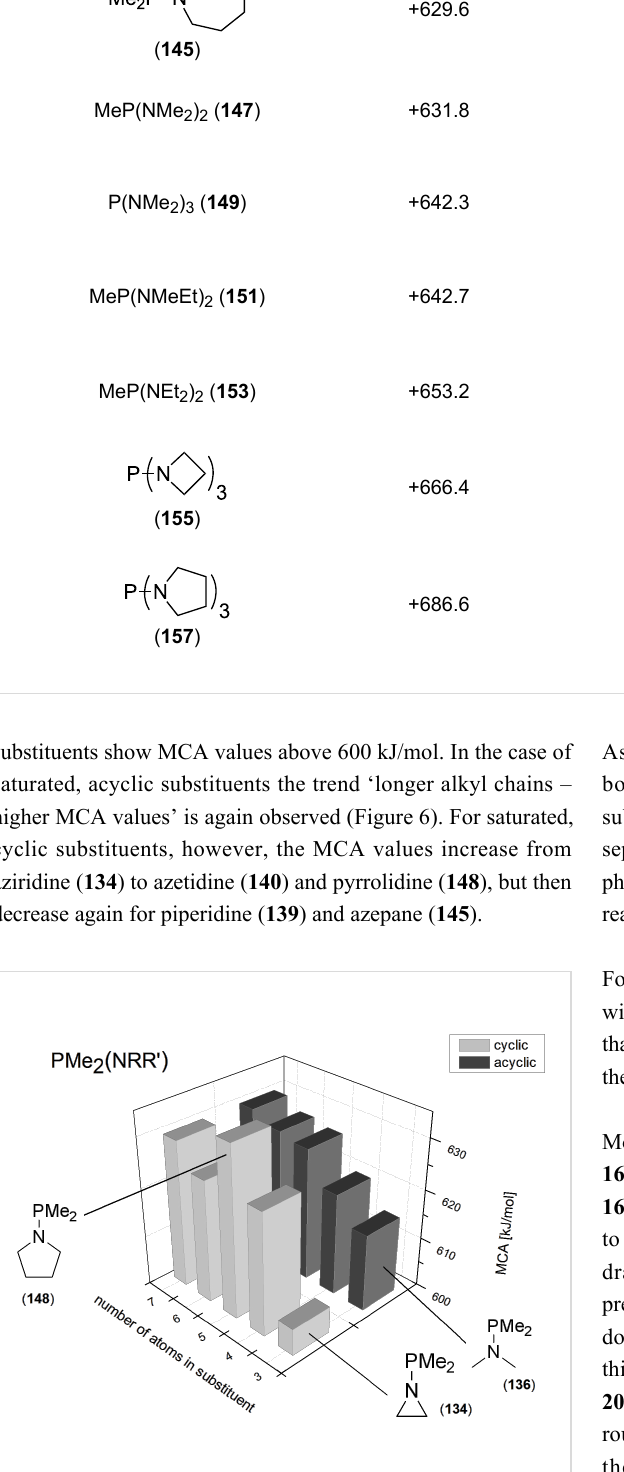
Figure 6: MCA values of phosphanes Me 2 P–NR 2 with cyclic and acyclic amine substituents.